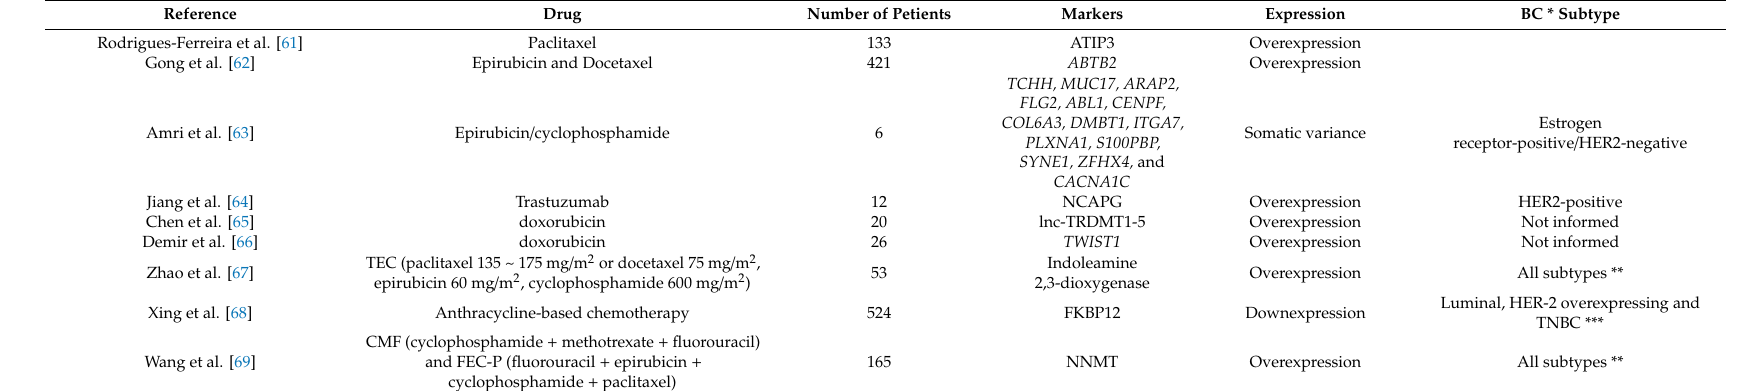
Table 2. Information from the nine recent studies that evaluated chemoresistance markers in BC tissue